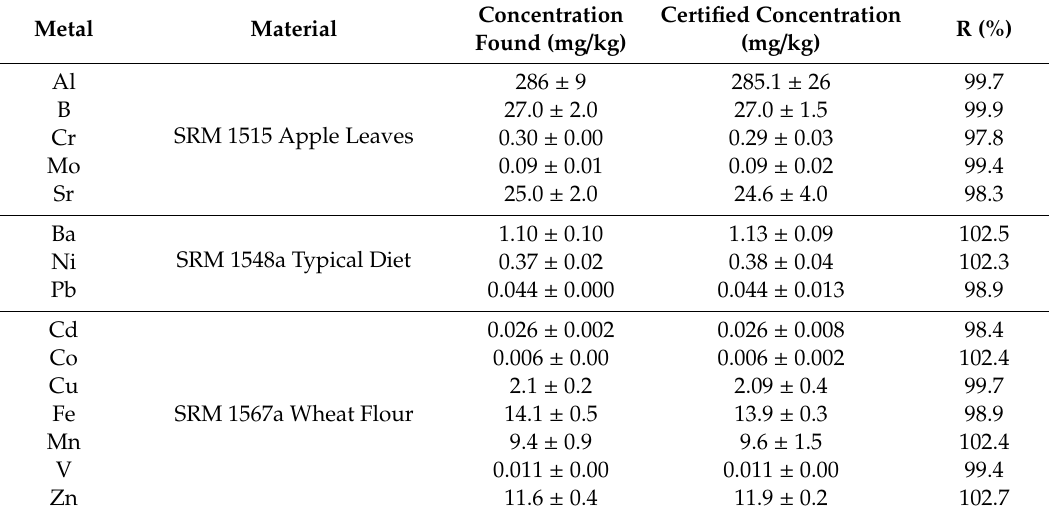
Table 2. Recovery study with the standard reference materials (SRM) for the analyzed